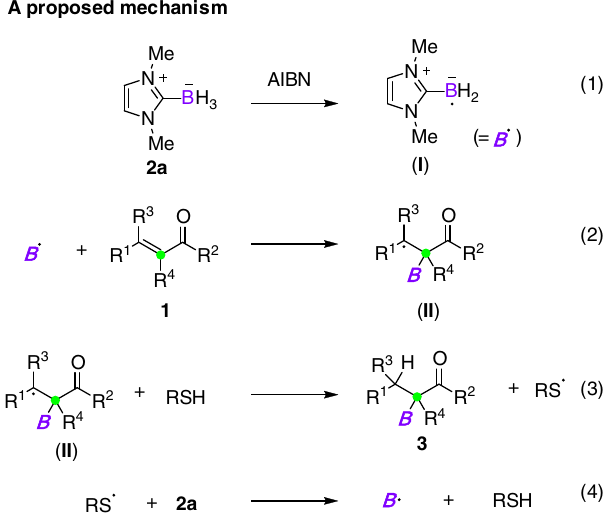
Fig. 3 Mechanism. A proposed radical chain process for hydroboration of 1